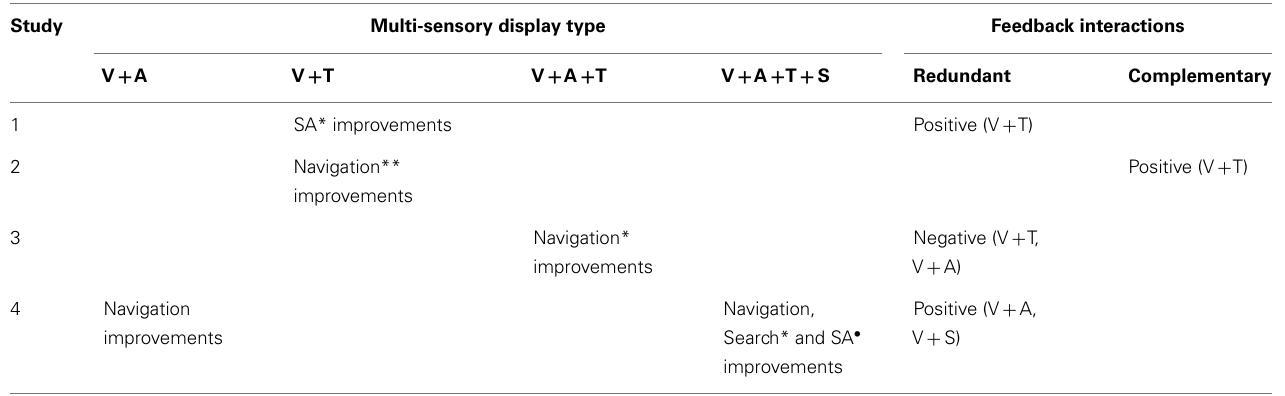
Table 9 | Summary of results for the four studies in terms of navigation and search performance and interactions between types of feedback .